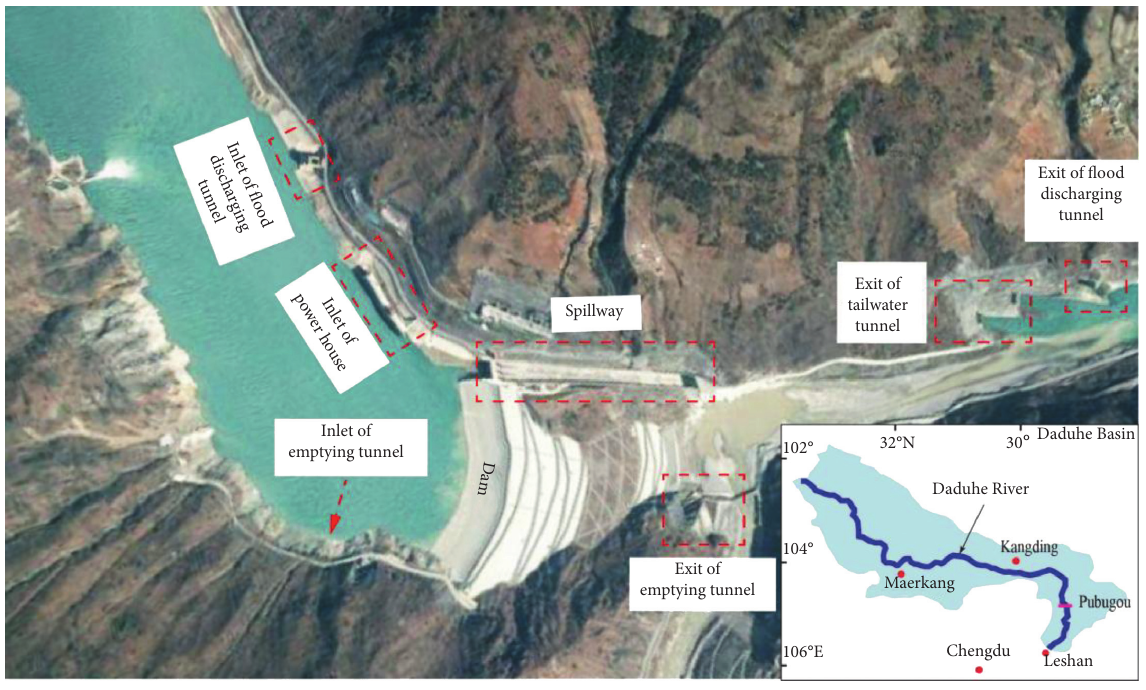
Figure 3: The layout of the PBG hydropower